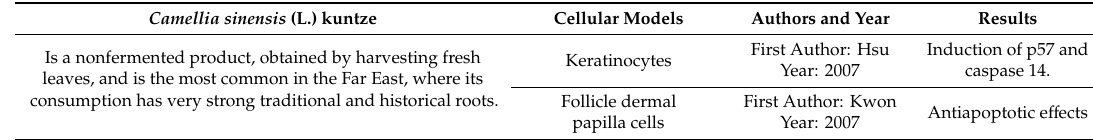
Table 5. Schematic representation of in vitro cellular models used to test the role of Camellia sinensis (L.)